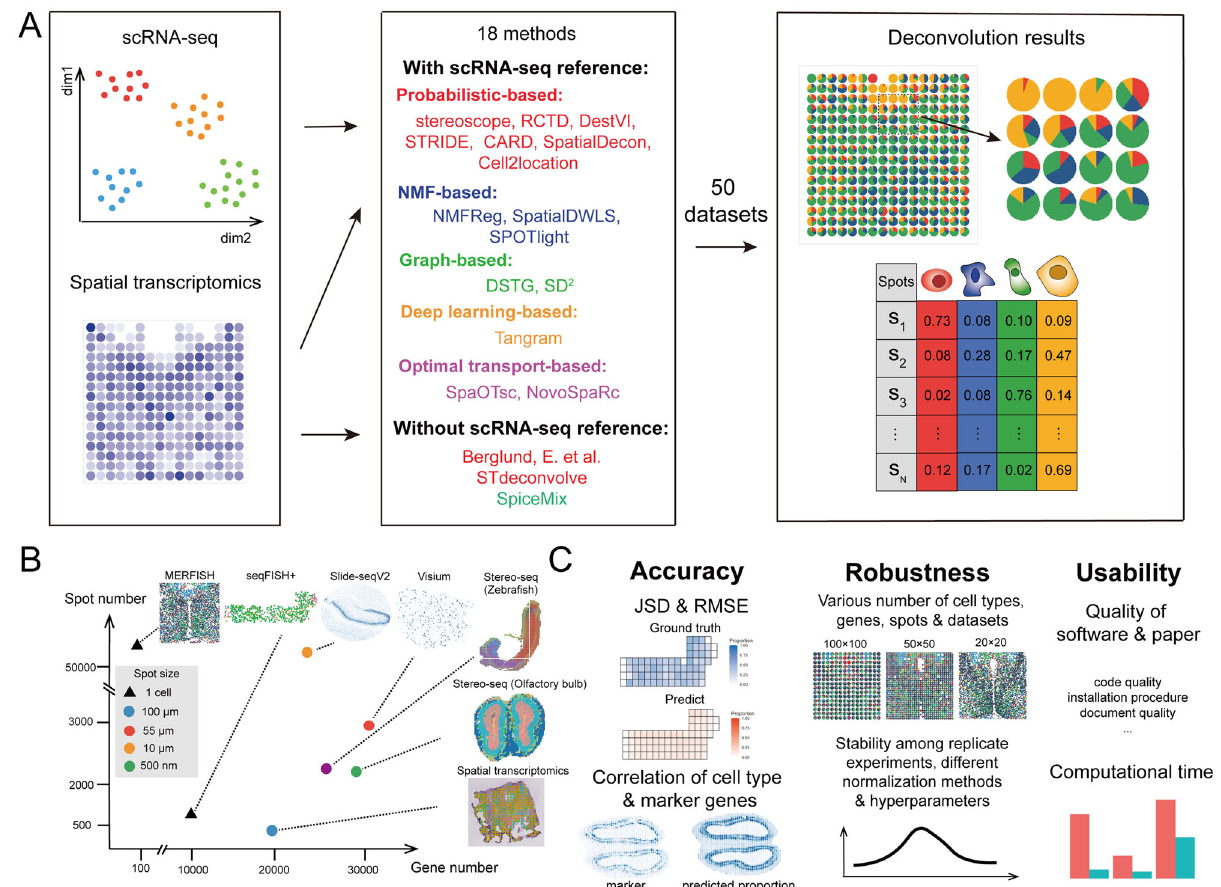
Fig. 1 | The summarization of benchmarking pipeline. A Eighteen cellular deconvolution methods, classi fi ed based on their data requirements and compu- tational techniques, were evaluated with 50 simulated and real-world spatial tran- scriptomicsdatasets. B Datasetsfromsixspatialtranscriptomicstechnologieswere